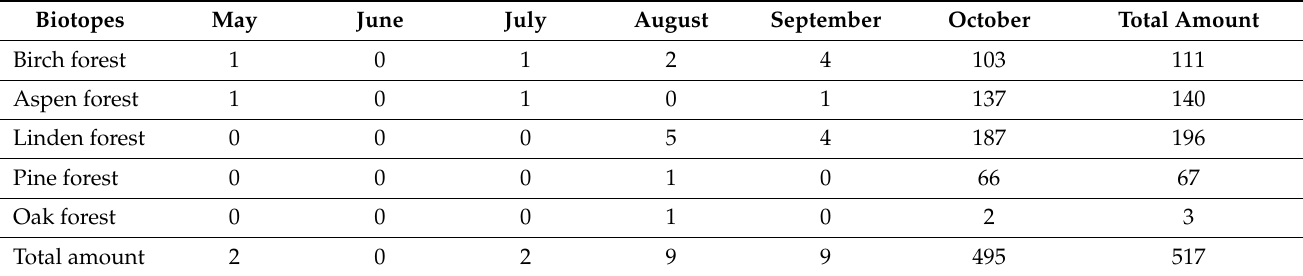
Table A3. Seasonal dynamics of Drosophila kuntzei in five biotopes.